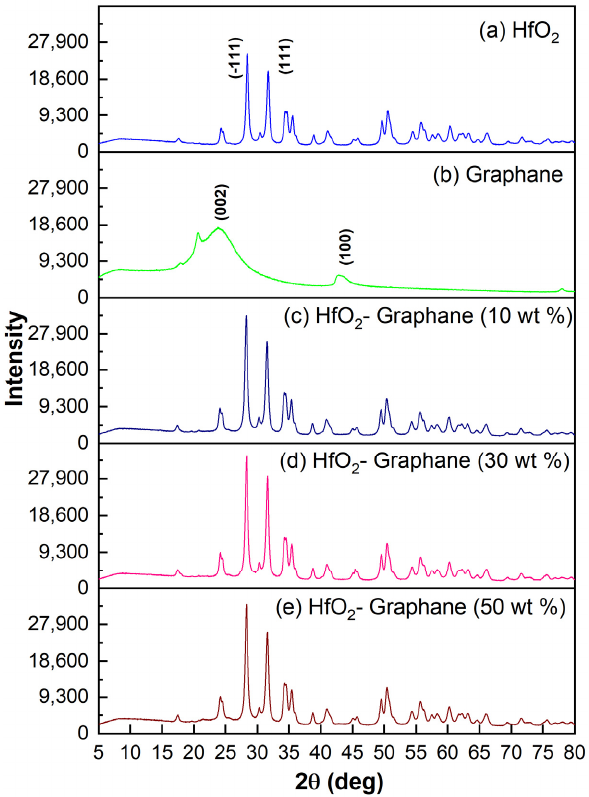
Figure 1. XRD pattern of ( a ) HfO 2 nanoparticles, ( b ) graphene, and ( c – e ) HfO 2 -graphene (10, 30, and 50 wt%) nanocomposites.